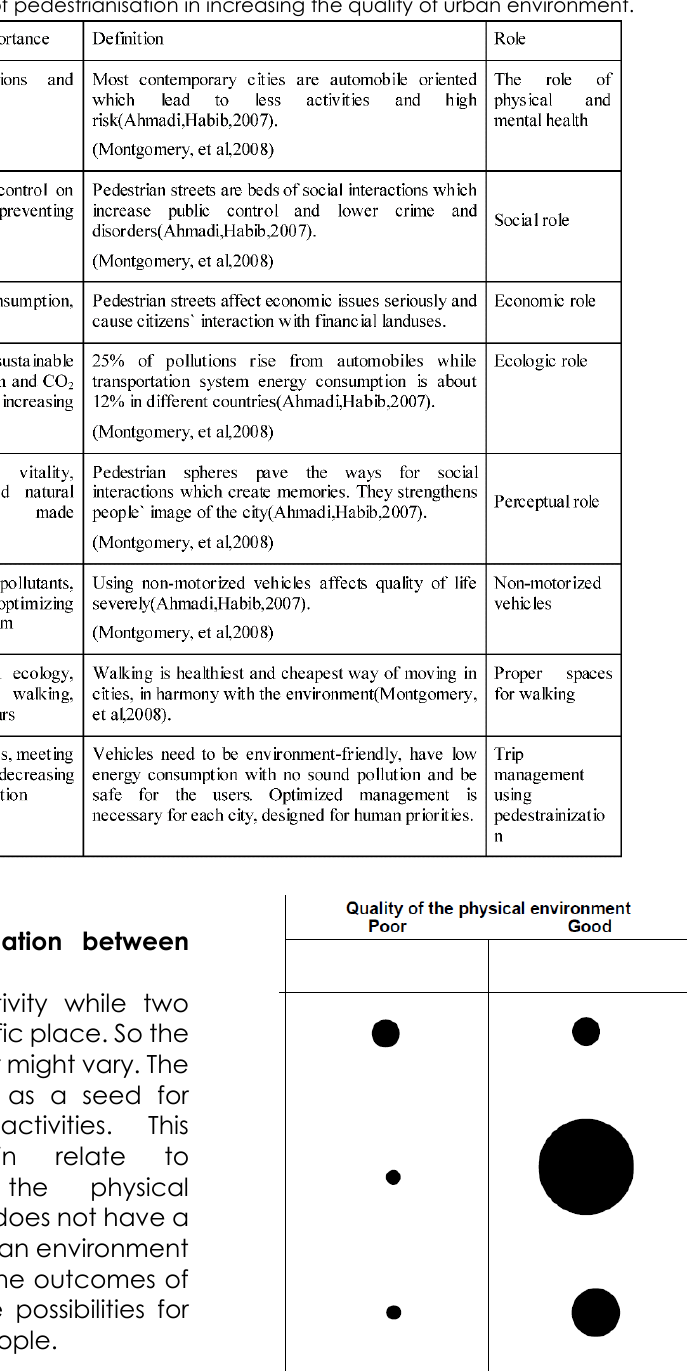
Figure 1. The interrelation between walkability and quality if physical environment based on Gehl,